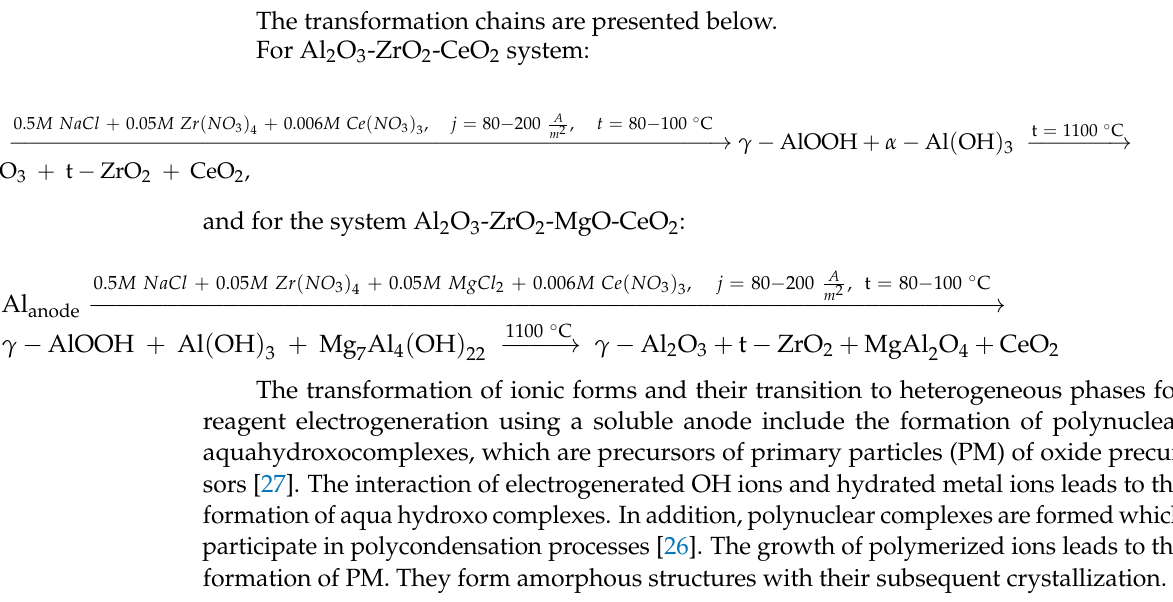
Figure 5. XRD patterns: ( a ) 10 wt% ZrO 2 -Al 2 O 3 -CeO 2 ; ( b ) 1 wt% ZrO 2 -Al 2 O 3 MgO-CeO 2 . The transformation chains are presented